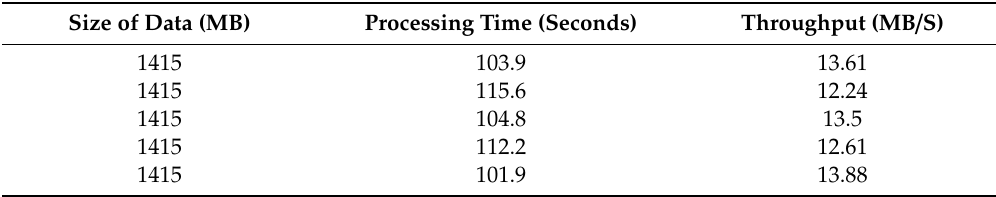
Table 2. Raspberry Pi (Fog device) throughput results.